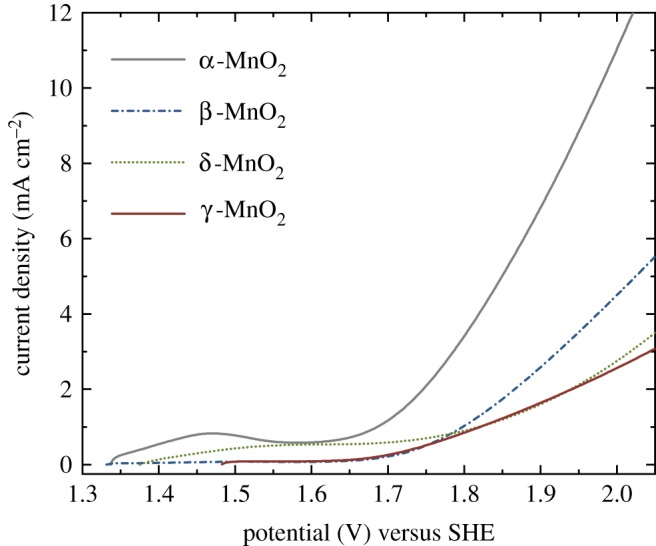
LSV curves of the Mn oxide samples synthesized by industrial processes in 0.5 M Na2SO4 aqueous solution (pH 0.2 adjusted by addition of H2SO4) (scan rate: 10 mV s−1). The amount of deposited Mn oxides was approximately 0.14 mg cm−2.